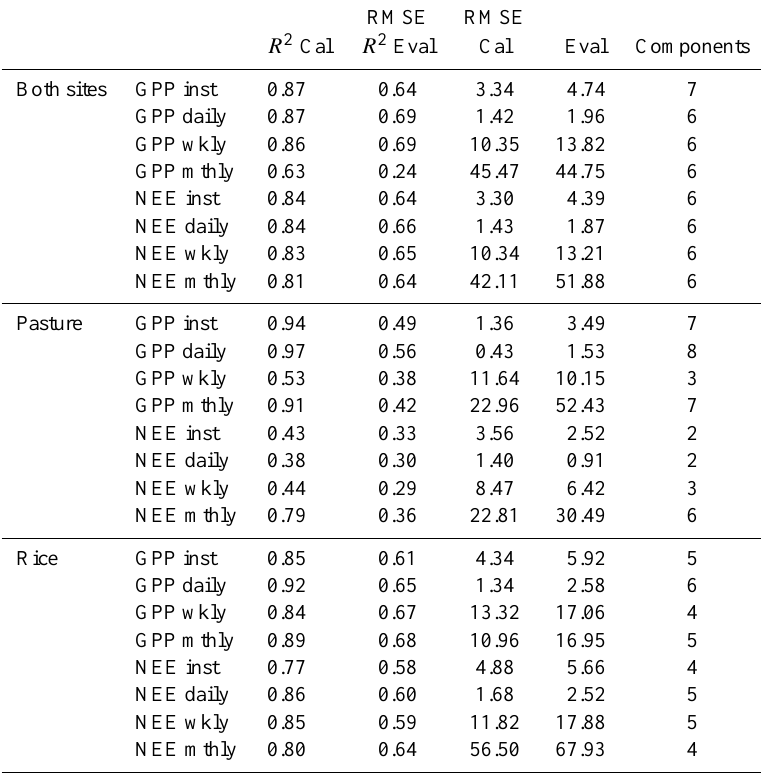
Table 1. Fit statistics for the bootstrapped PLSR model. The mean R 2 and root mean squared error (RMSE) is provided for the PLSR Calibration fitting (Cal) and the calibration Evaluation (Eval) during the PLSR model development, conducted with 80% of the total data set. Units for instantaneous fluxes are µmolm − 2 s − 1 , and for daily, weekly, and monthly values are gCm − 2 . In general, models with daily integrated GPP and NEE had the best fit compared with models that fit the flux data from other timescales. The PLSR fit for GPP using the hyperspectral reflectance data tended to outperform the fit of NEE across the data sets and models. The statistical fit of the PLSR models was higher at the Rice site compared with the Pasture. “inst” stands for